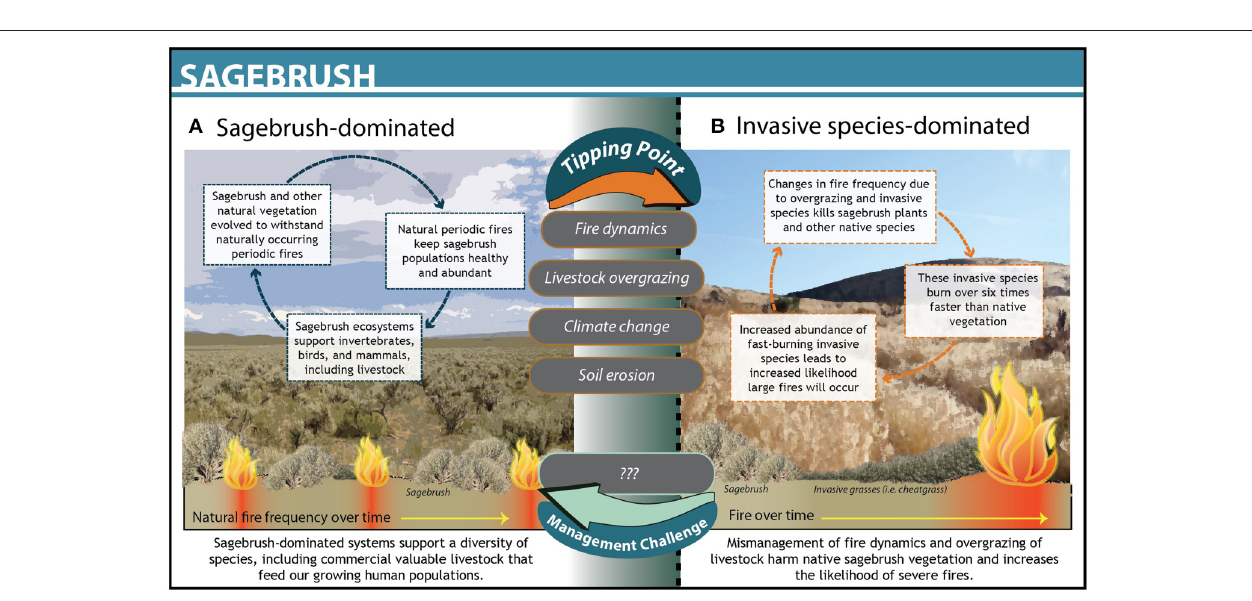
FIGURE 3 | The dynamics and structure of Sagebrush grasslands in Nevada before (A) and after (B) crossing a threshold. The upper gray text bubbles between states denote drivers that pushed the system across a threshold. No management actions were taken in this